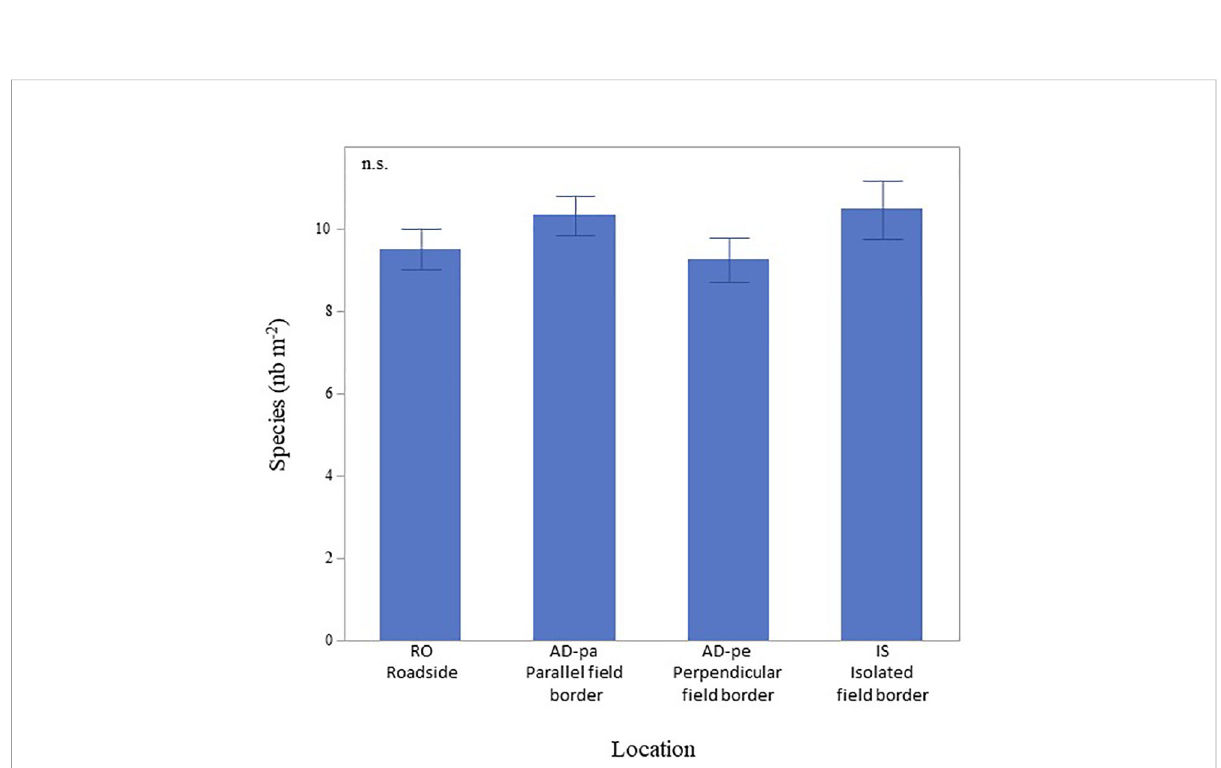
FIGURE 4 Species richness along roadsides and fi eld borders. Values are not signi fi cantly different (n.s. p =0.3285). Error bars indicate